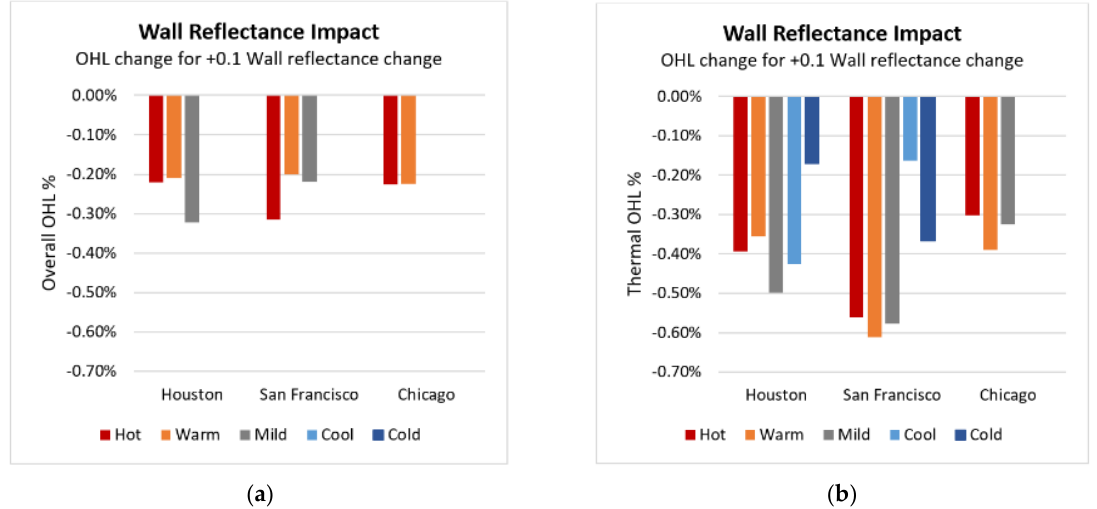
Figure 11. Impact of a 0.1 W/m 2 -K decrease in roof insulation U-value on overall ( a ) and thermal ( b ) OHL.